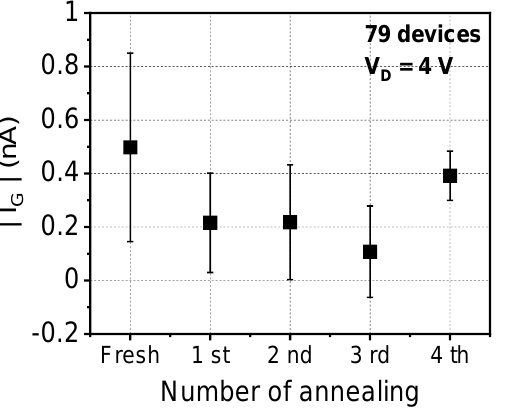
Figure 5. Extracted gate leakage (I G ) after iterative HPD. The I G was extracted at V G = − 3 V.